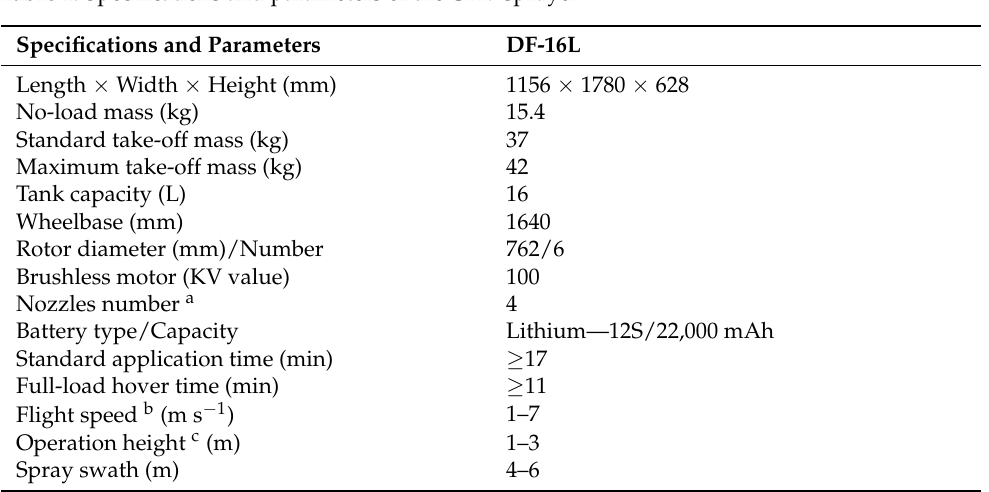
Figure 1. Multirotor UAV sprayer used in this work. Table 1. Specifications and parameters of the UAV